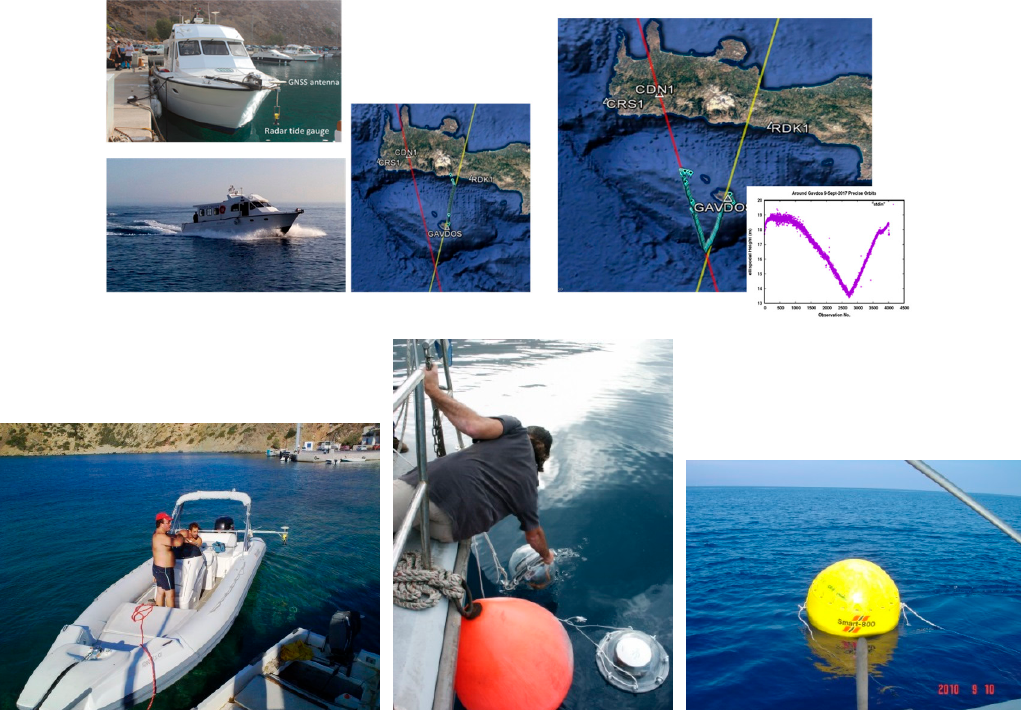
Figure 17. Sea-surface campaigns over the satellite pass with the boat to verify the geoid and mean dynamic models in the calibrating regions of Gavdos.